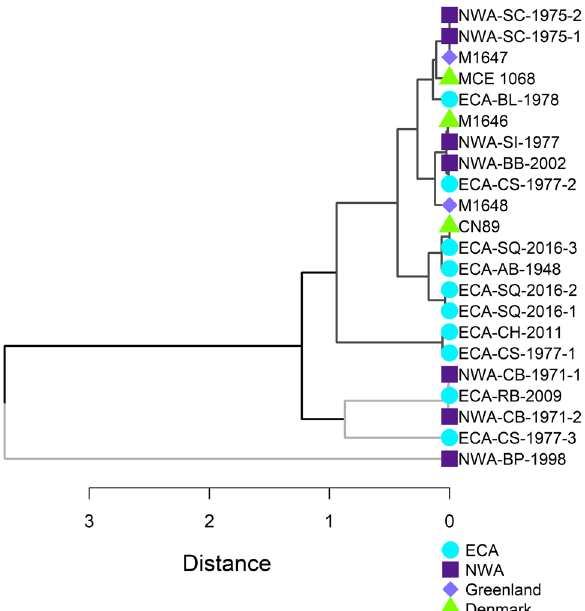
Figure 3. Hierarchical cluster analysis of killer whale dentine δ 18 O P based on Euclidean distances and average linkage produced clusters that do not align with stranding locations in the eastern Canadian Arctic (ECA) and northwest Atlantic (NWA). The two most distant (bottom) clusters comprising five whales, indicated with light grey branches, had higher δ 18 O P and broader inferred distributions at lower latitudes than whales indicated by dark grey branches (see Fig.